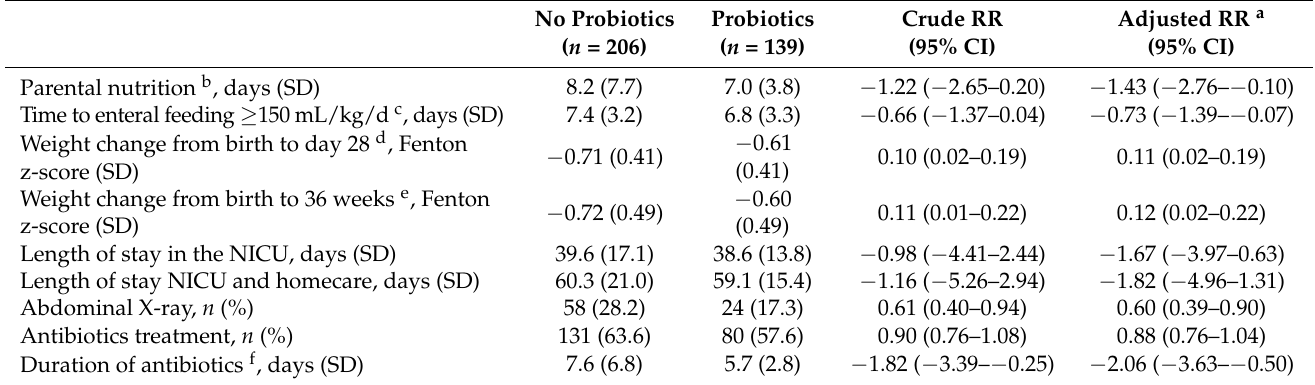
Table 3. Feeding tolerance, growth, and other secondary outcomes, in 345 very preterm infants.